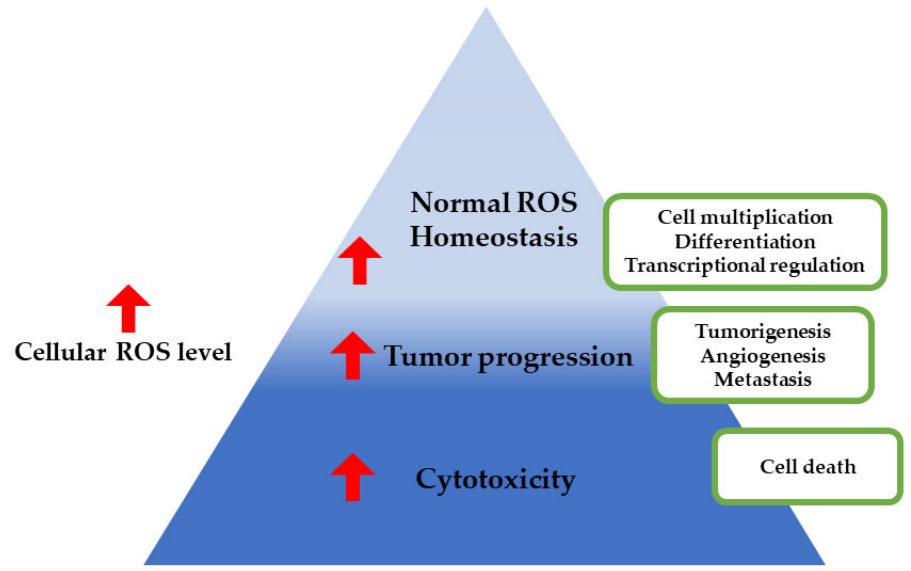
Figure 9. Different ROS concentrations in tumor cells are graphically represented.